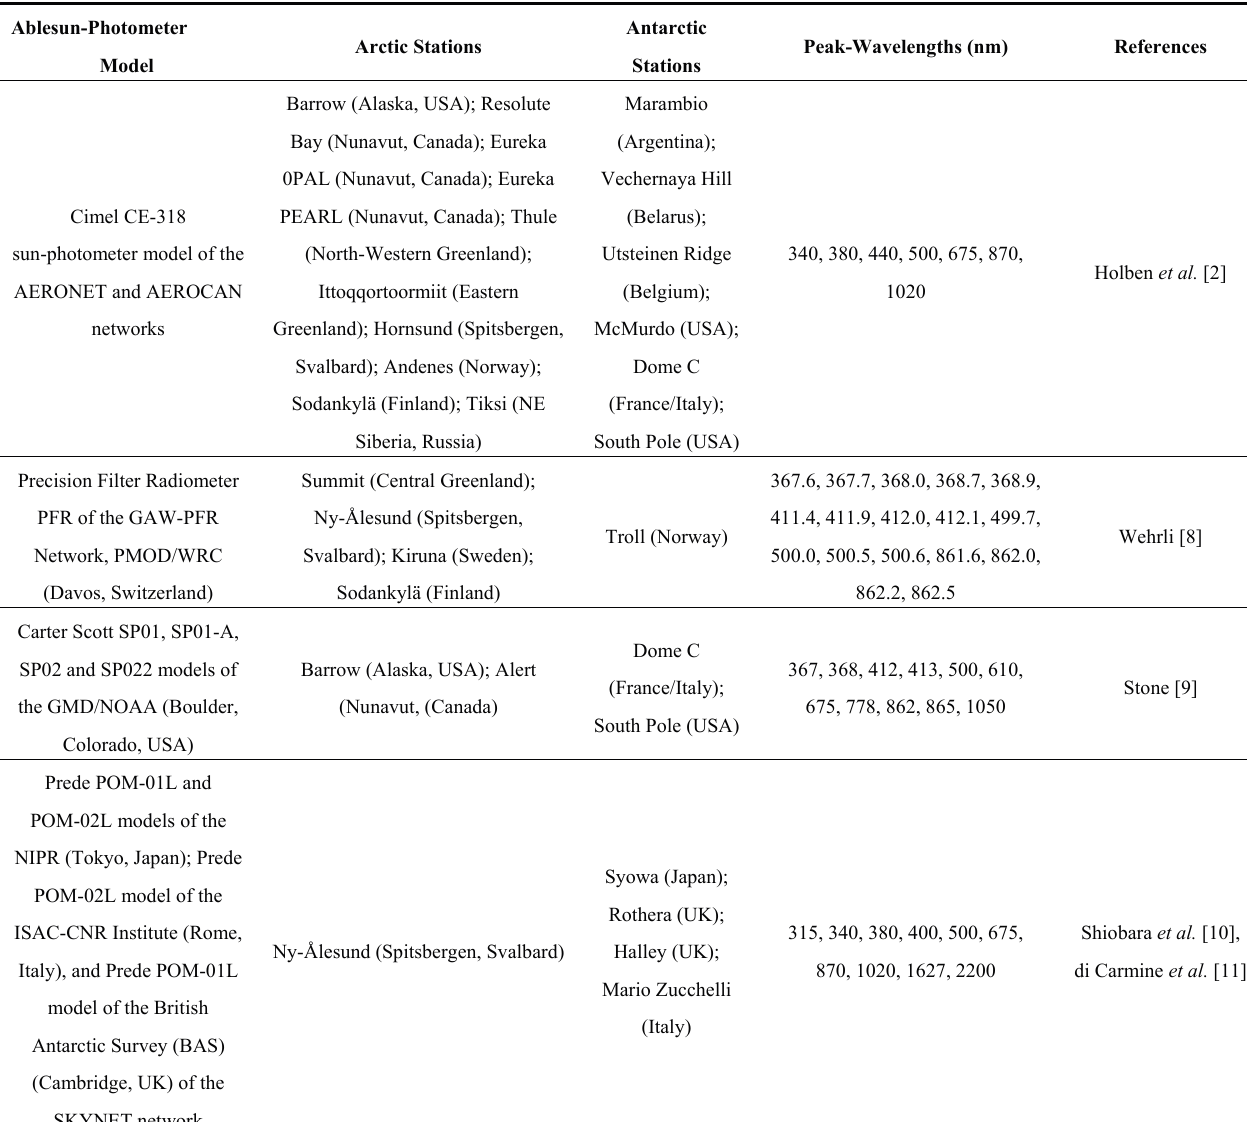
Table 1. List of the multispectral sun-photometer models employed at the Arctic and Antarctic stations of the various networks, with the sun-photometric channel peak-wavelengths at which aerosol optical depth τ a ( λ ) is routinely measured. The last column provides the main references where the technical characteristics of the various instruments are